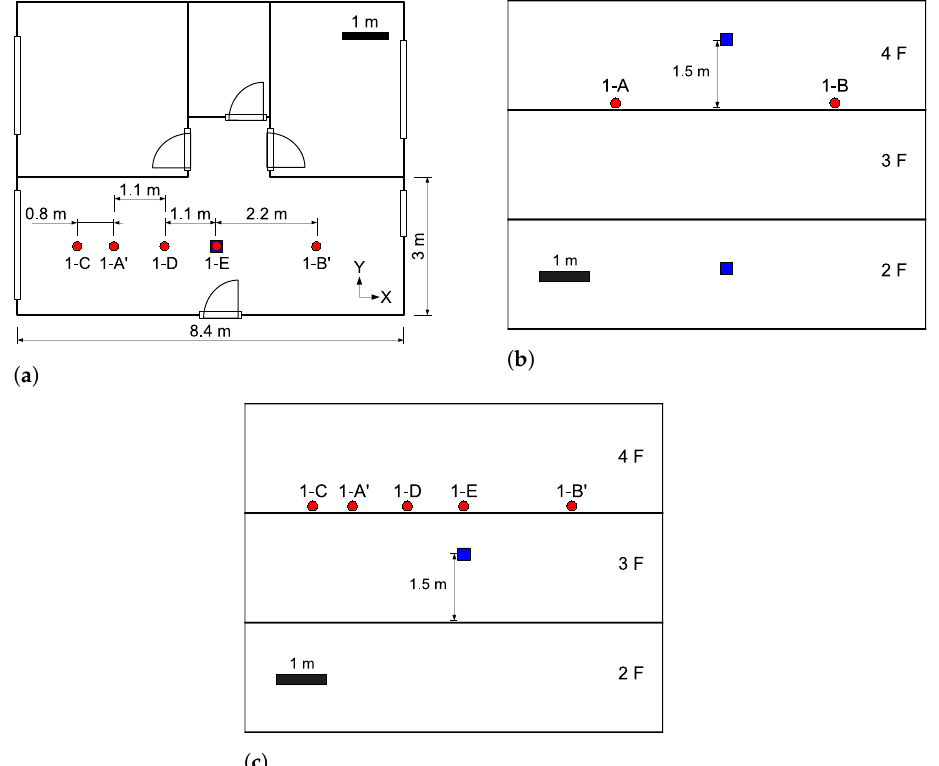
Figure 2. Noise source ( (cid:13) ) and receiver ( (cid:3) ) positions used for inter-floor noise generation at APT